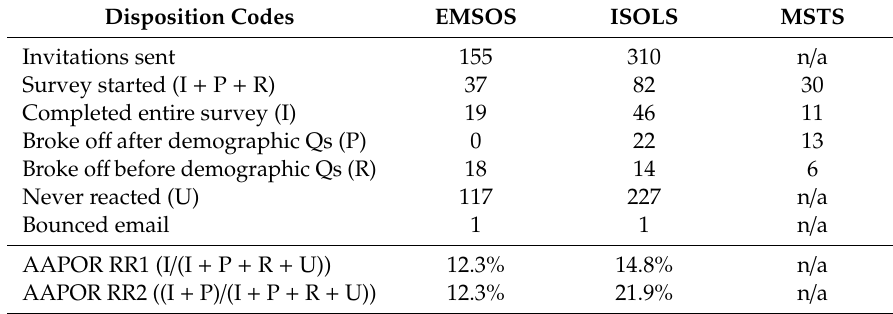
Table 1. Participation behavior and American Association for Public Opinion Research (AAPOR) response rates.